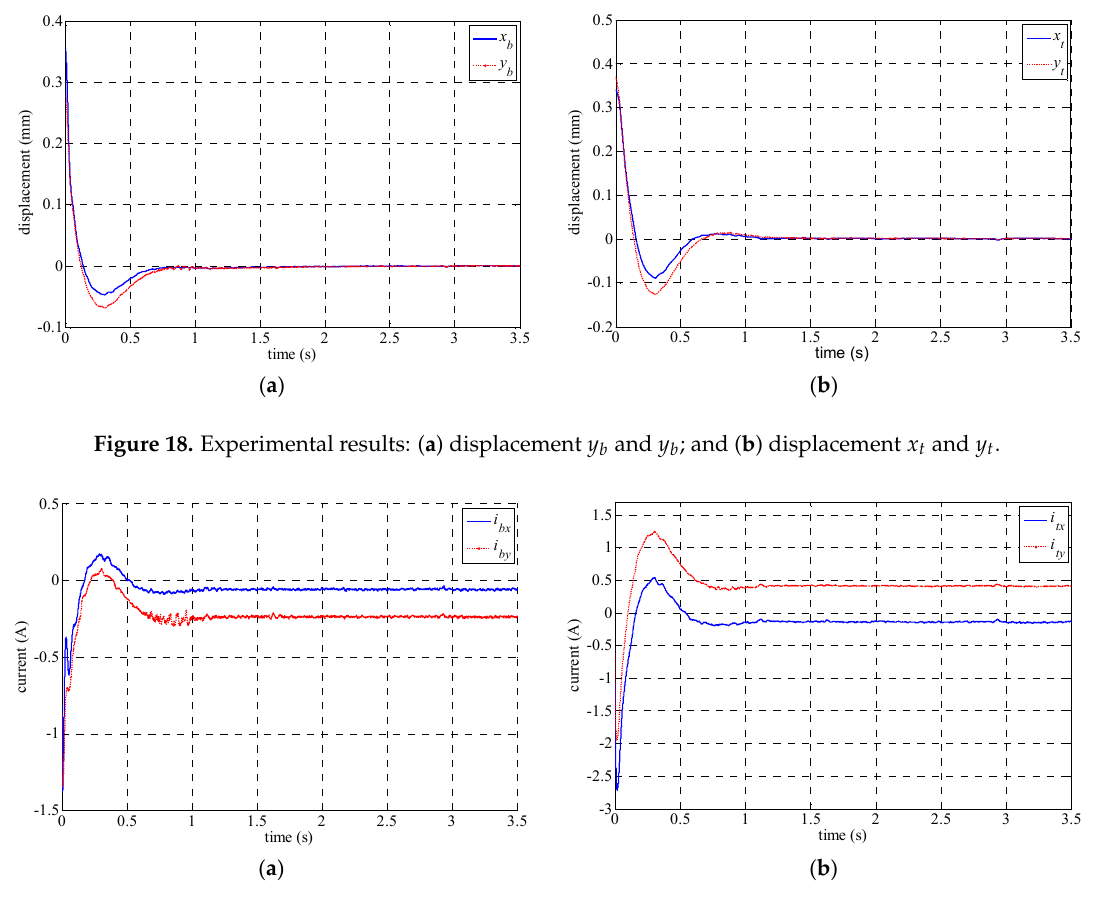
Figure 19. Experimental results: ( a ) control currents i bx and i by ; and ( b ) control currents i tx and i ty